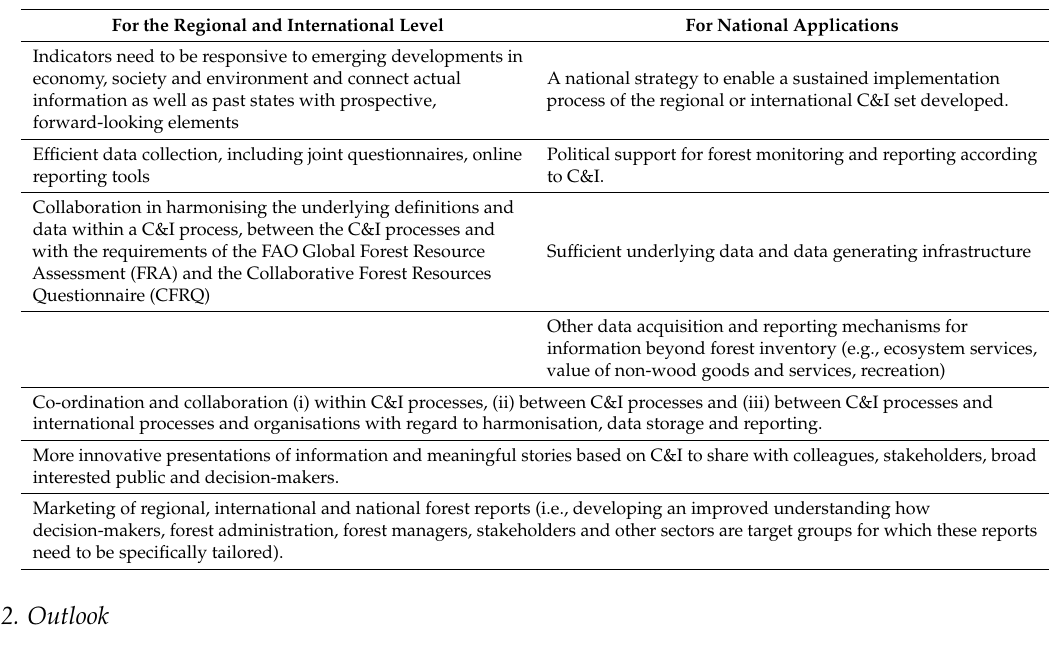
Figure S1: Allocation of indicators from the C&I processes to criteria/thematic elements., Figure S2: Allocation of indicators to criteria/thematic elements in each C&I process, Figure S3: Allocation of quantitative indicators to SFM related issues in the C&I processes, Figure S4: Allocation of quantitative indicators from C&I processes to SFM related issues, Figure S5: Allocation of qualitative indicators to selected SFM related issues, Figure S6: Allocation of qualitative indicators of the C&I processes to SFM related